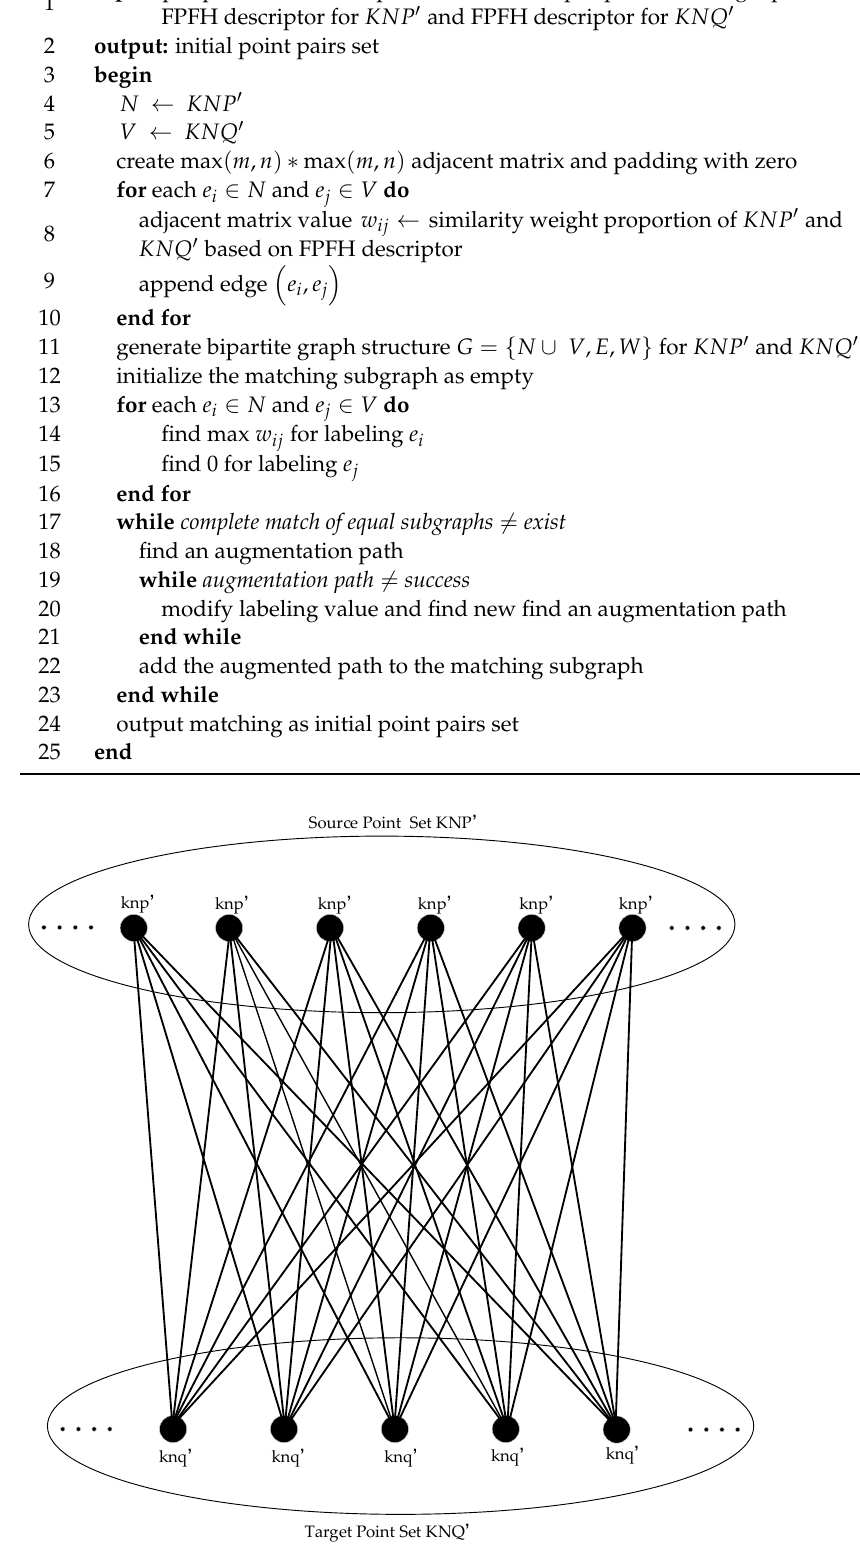
Figure 3. The bipartite graph structure representation of the 𝐾𝑁𝑃′ and 𝐾𝑁𝑄′ .